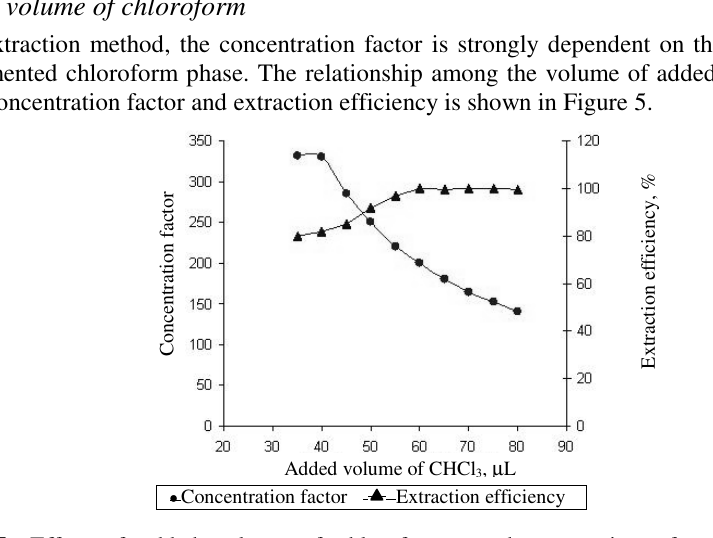
Figure 5. Effect of added volume of chloroform on the extraction of palladium and concentration factor. ( Conditions: Pd(II)50.0 ngmL -1 ; TMK 5.0 × 10 -5 mol L -1 ; TBA + 2.0 × 10 -2 mol L -1 ; NaClO 4 2.5 × 10 -2 mol L -1 and pH = 3.0